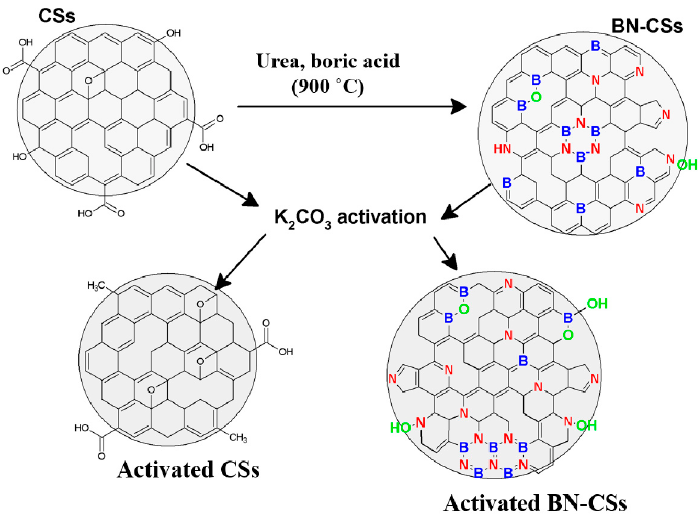
Scheme 1. Proposed mechanism for the boron and nitrogen co-doping and activation of the CSs.